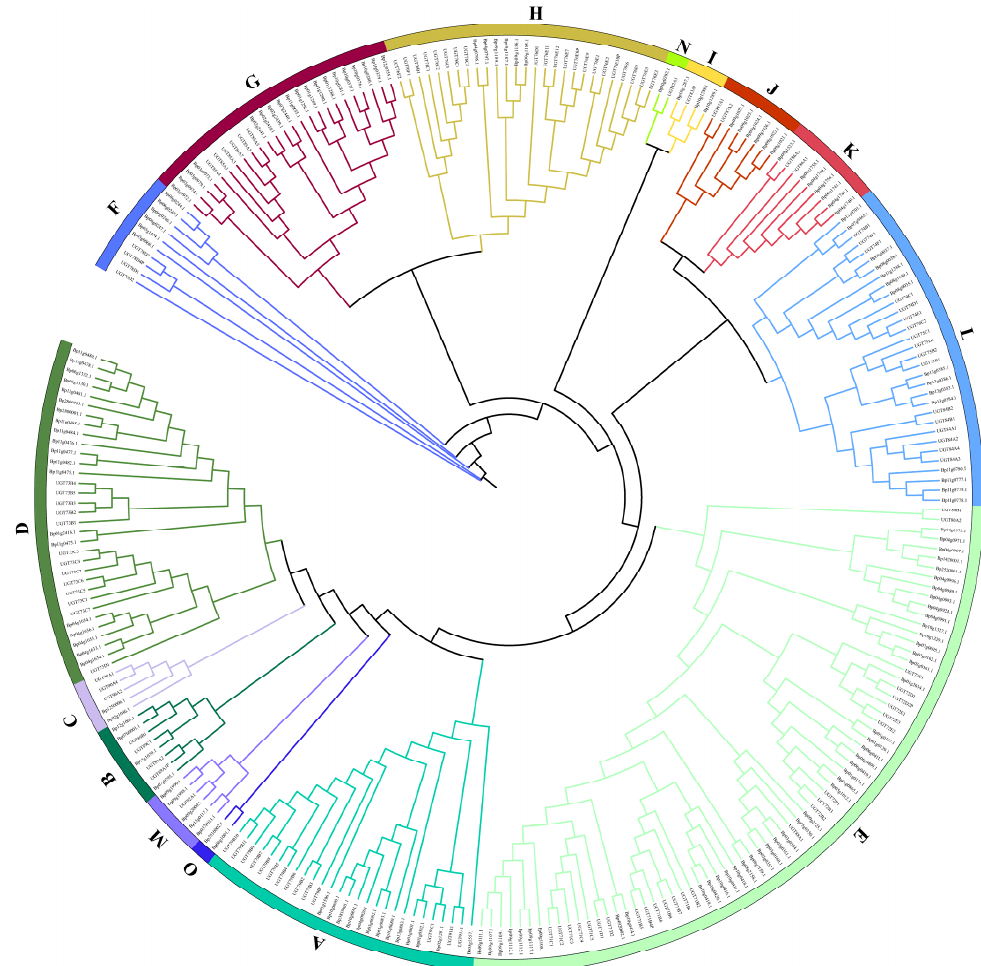
Figure 1. Phylogenetic analysis of the BpUGT proteins among B. papyrifera and A. thaliana . The full-length amino acid sequences of the BpUGT proteins from B. papyrifera and A. thaliana were aligned, and the phylogenetic tree was constructed by IQTREE using the maximum likelihood (ML) method with 1000 bootstrap replicates. The numbers on each branch line represent the bootstrap values. Different colored strips indicate subfamilies.